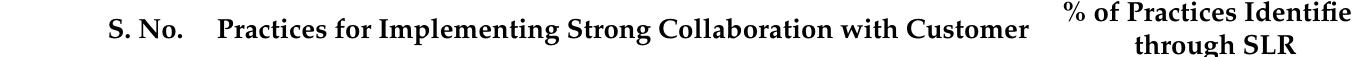
Table 11. Practices for implementing strong collaboration with